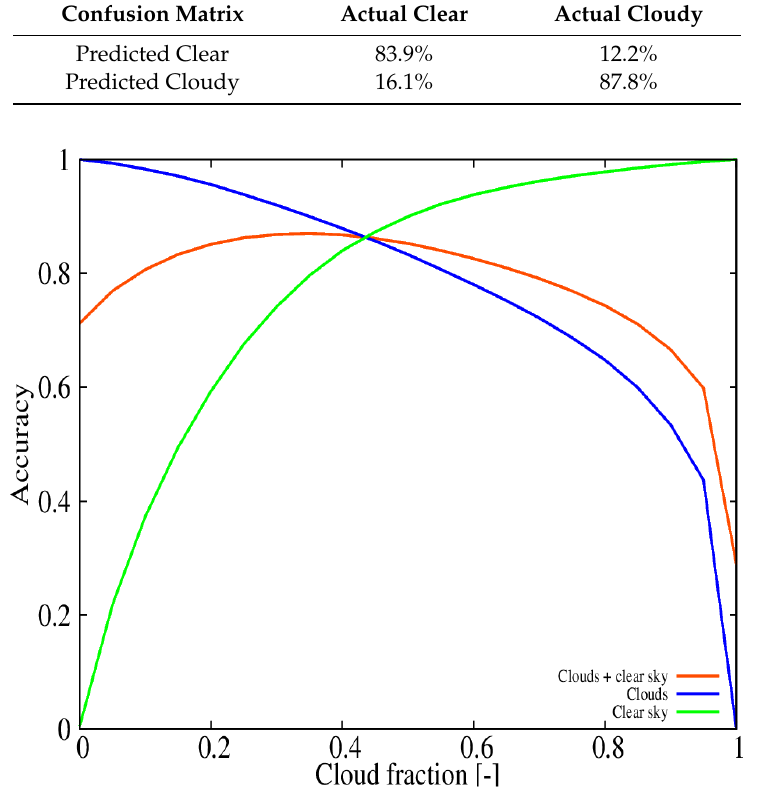
Figure 7. Accuracy of the optimal RF configuration calculated with the testing dataset.